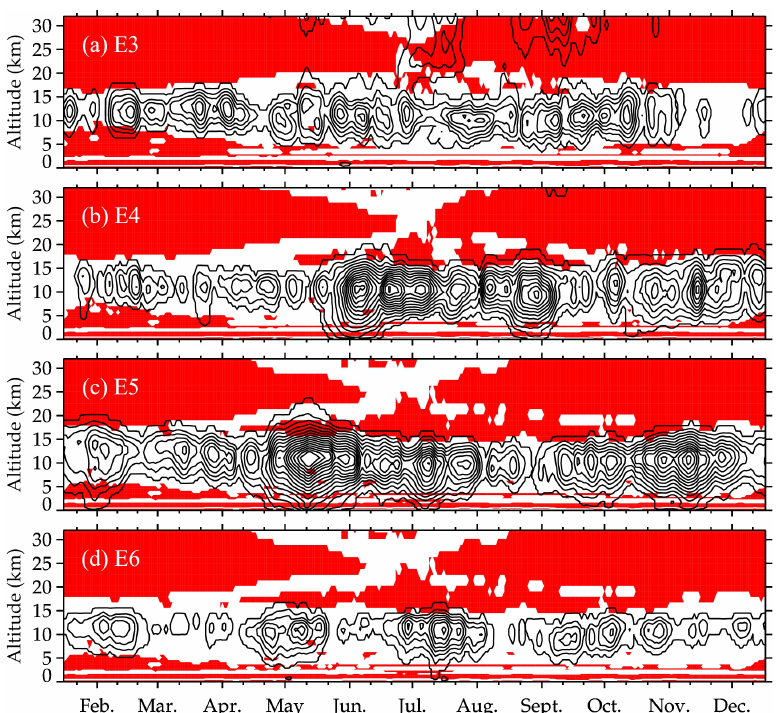
Figure 6. Time–altitude sections of the refractive index squared and zonal wind amplitudes of: ( a ) E3; ( b ) E4; ( c ) E5; ( d ) E6 10DWs at 32 ◦ S in 2020. Regions with a negative refractive index squared are shaded in red, and the black contours denote the zonal wind amplitudes of the 10DWs. Contours are from 2 ms − 1 at an interval of 0.5 ms − 1